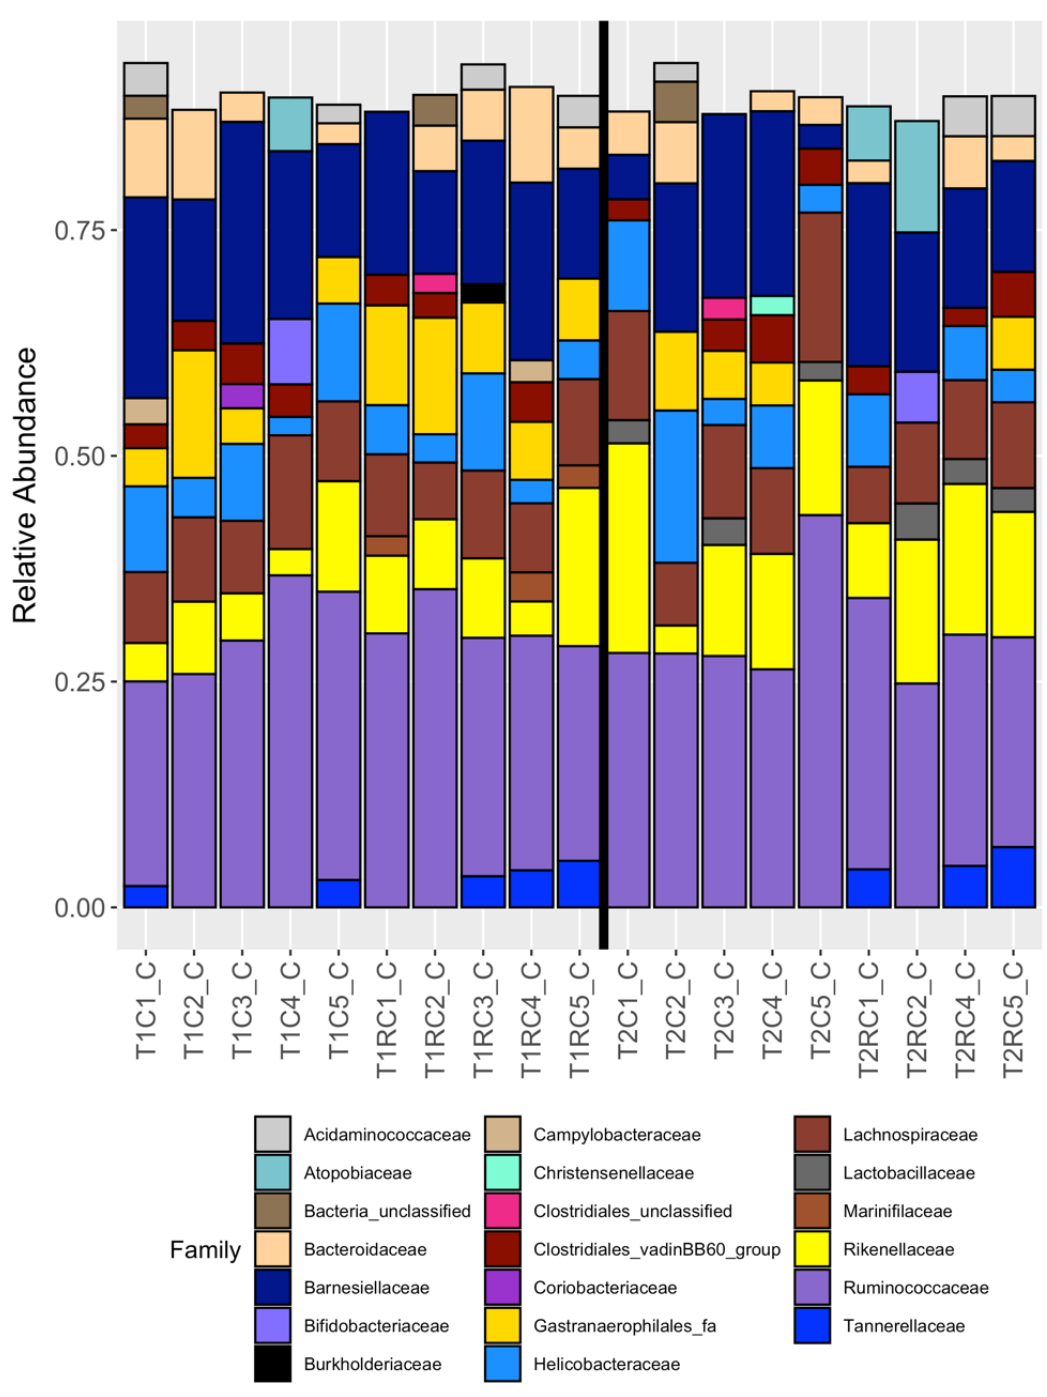
Figure 2. The relative abundance of families observed for each cecal content samples that had >= 3005 reads; n = 19. The vertical black line divides samples belonging to the two dietary treatments.